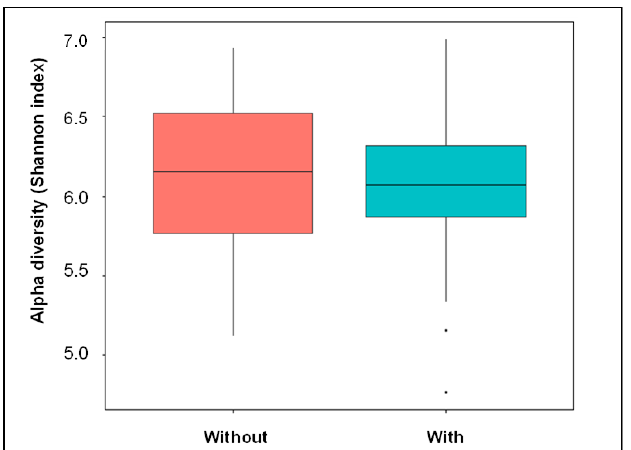
Figure 2. Comparison of the alpha diversity of patients without and with a combined cardiovascular endpoint event using Shannon index applied at the OTU level.